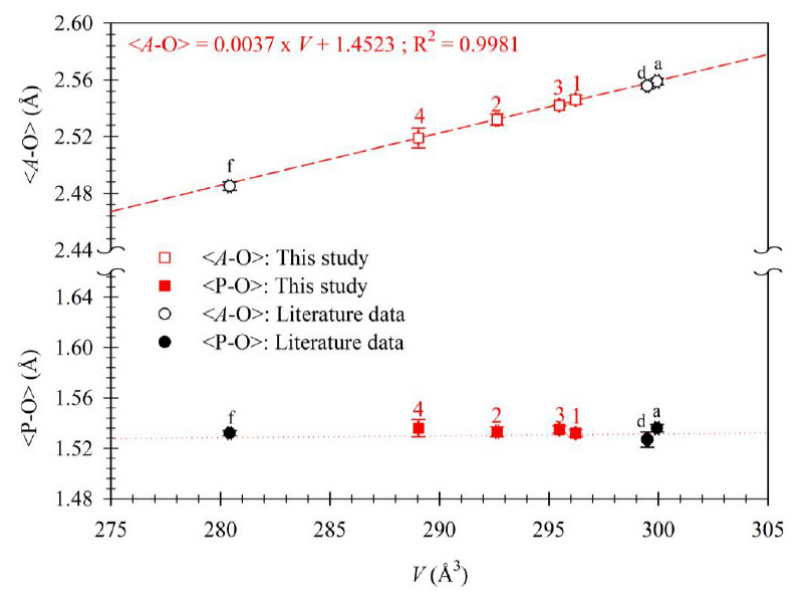
Figure 3. Average < A ‐ O> and <P ‐ O> distances in monazite. The dashed linear line is fitted to data from this study. The literature data are a: monazite ‐ Ce and d: CePO 4 [8], and f: [Sm 0.5 Tb 0.5 ]PO 4 [37]. The average < A ‐ O> distances vary linearly with V . Average <P ‐ O> = 1.528 Å (dotted line).